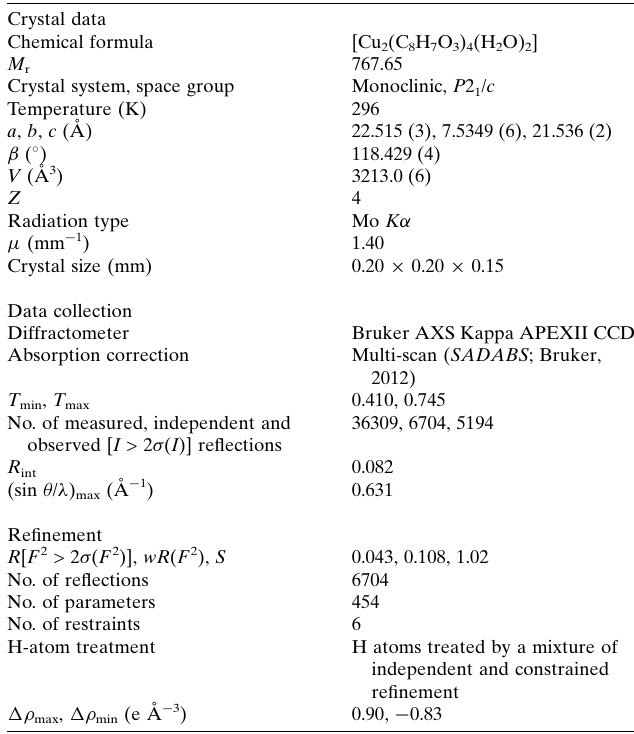
Table 2 Experimental details. Crystal data Chemical